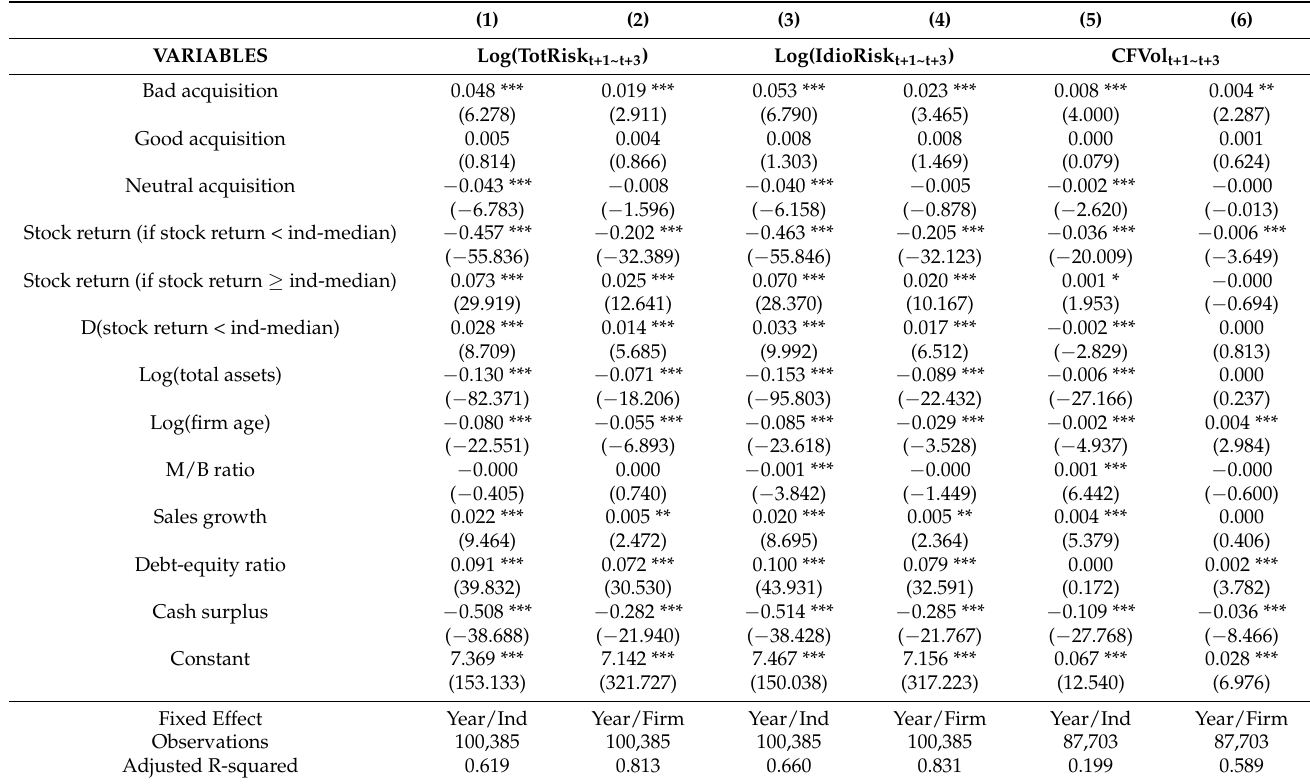
Table 6. Alternative risk measures. This table presents the OLS regression results for the sample of firm-year observations between 1990 and 2015. The dependent variables in Columns (1), (2), and (3) are TotRisk, SysRisk, and IdioRisk in fiscal years t+1 to t+3. The dependent variable in Columns (4) and (5) is the standard deviation of quarterly earnings in fiscal years t+1 and t+1 to t+3. Other variable definitions are in the Appendix A. All regressions control for fiscal-year fixed effects and firm fixed effects whose coefficients are suppressed for brevity. t-statistics based on standard errors adjusted for heteroskedasticity (White 1980) and firm clustering are reported in parentheses. *, **, and *** denote statistical significance at the 10%, 5%, and 1% levels,